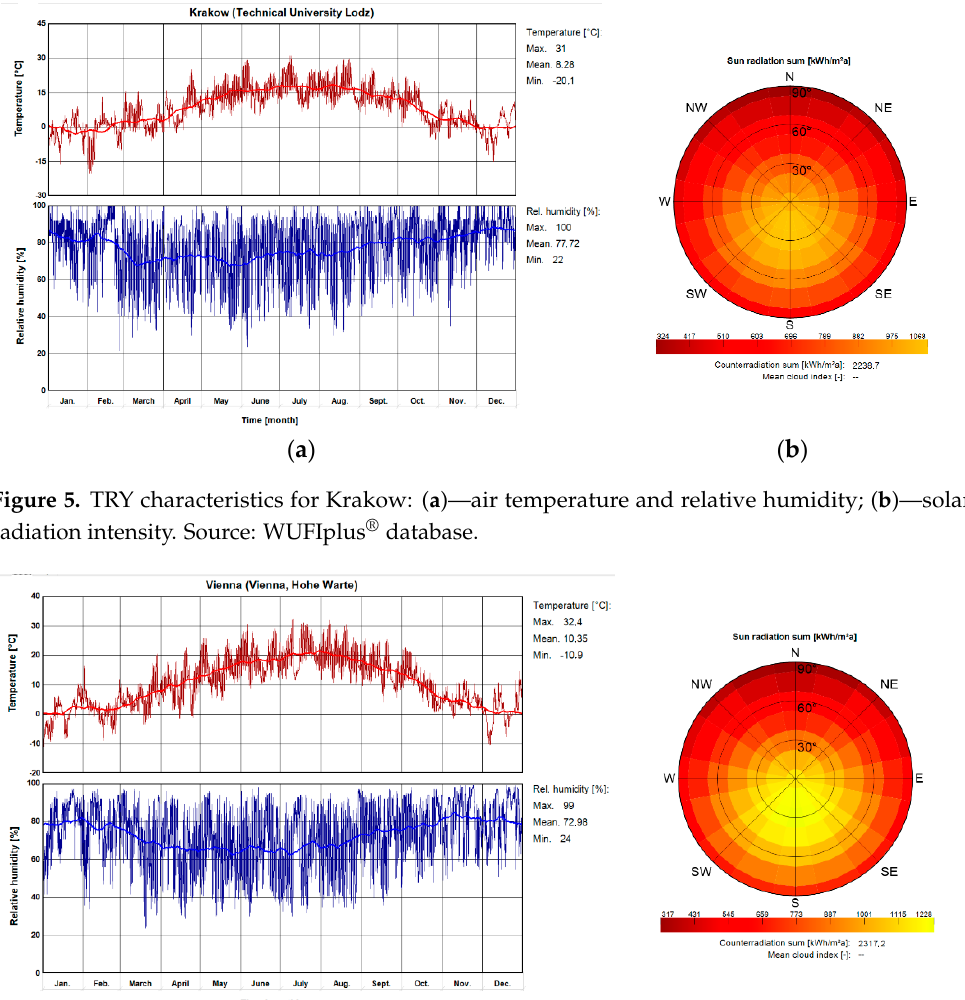
Table 1. Physical parameters of the soil and construction materials used in the calculations.